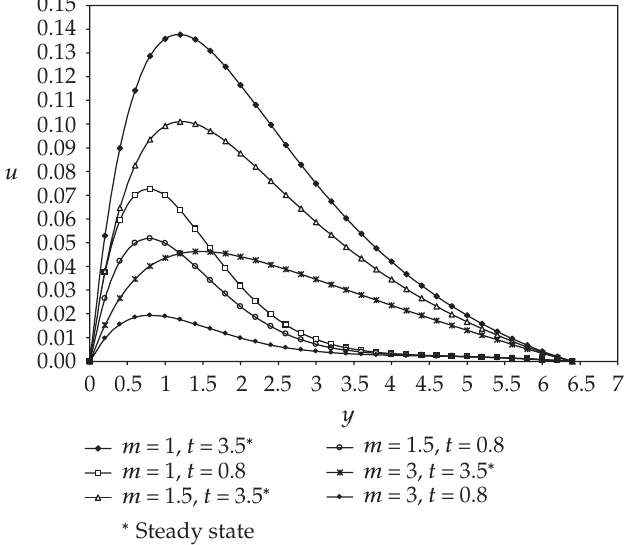
Figure 5.5 . Transient velocity profiles for the di ff erent values of m and for the values x = 0 . 5, F = 0 . 01, M = 1, and Pr = 0 .